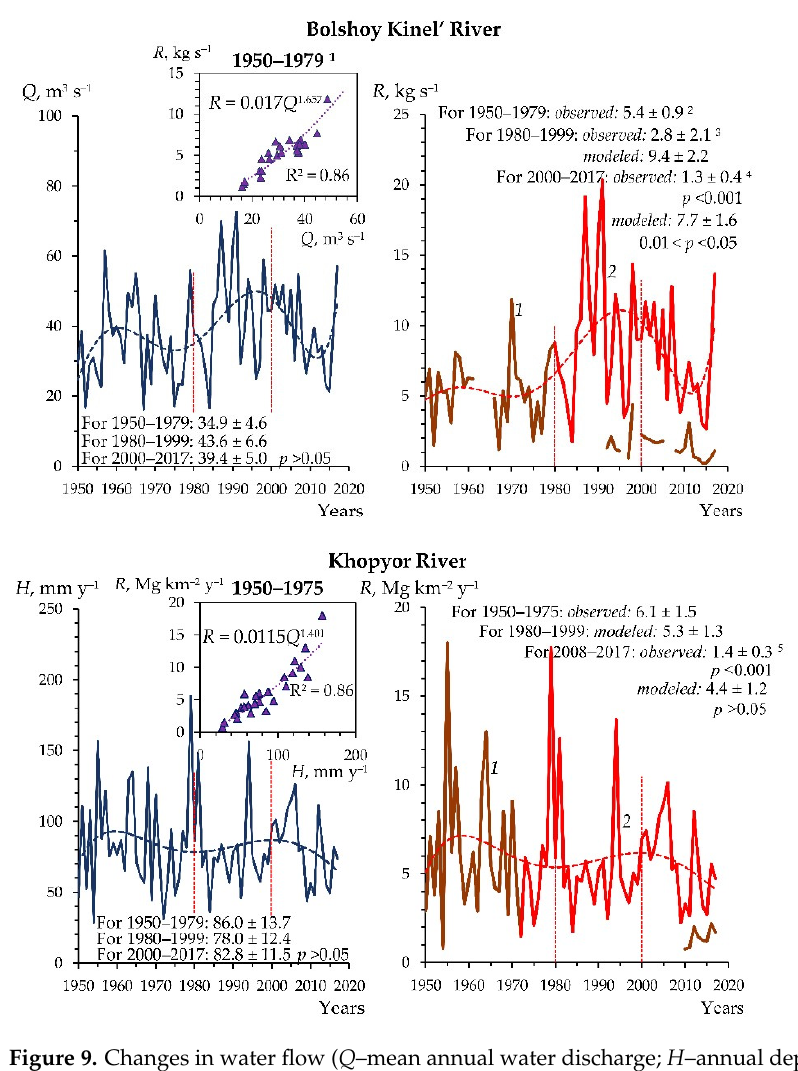
Figure 9. Changes in water flow ( Q –mean annual water discharge; H –annual depth of surface water runoff) and suspended sediment load/yield ( R ; 1 —observed, 2 —modeled according to the power equation of the relationship between two variables) in the Bolshoy Kinel’ River at Timashevo and the Khopyor River at Besplemyanovsky (see Figure 2B and Table 1) during 1950–2017. The dashed line is a fifth-degree polynomial trend; p –the probability of statistically significant differences in average values between 1950–1975/1979 and 2000/2008–2017 (Student’s t -test). 1 Without 1957, 1966, and 1979; 2 Without 1963–1965; 3 For 1980, 1992–1995, 1997, and 1998; 4 Without 2006 and 2007; 5 Without 2009.